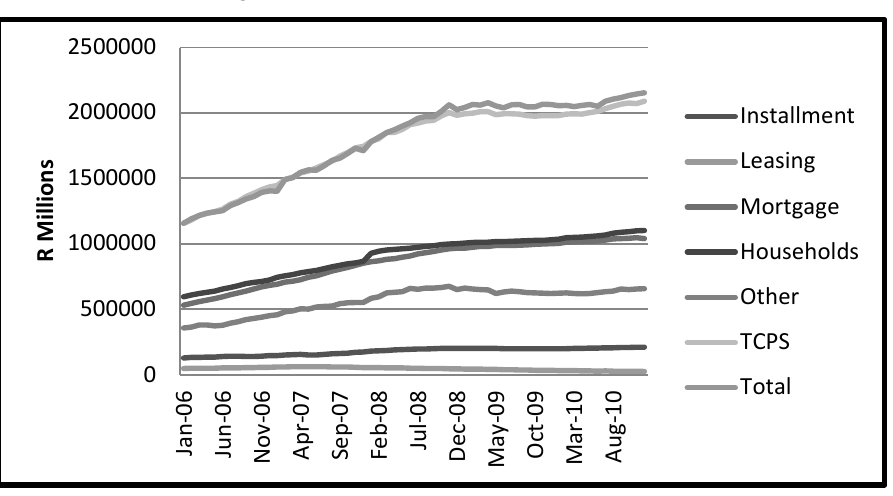
FIGURE 2: Credit extension by all monetary institutions, 2006-2010